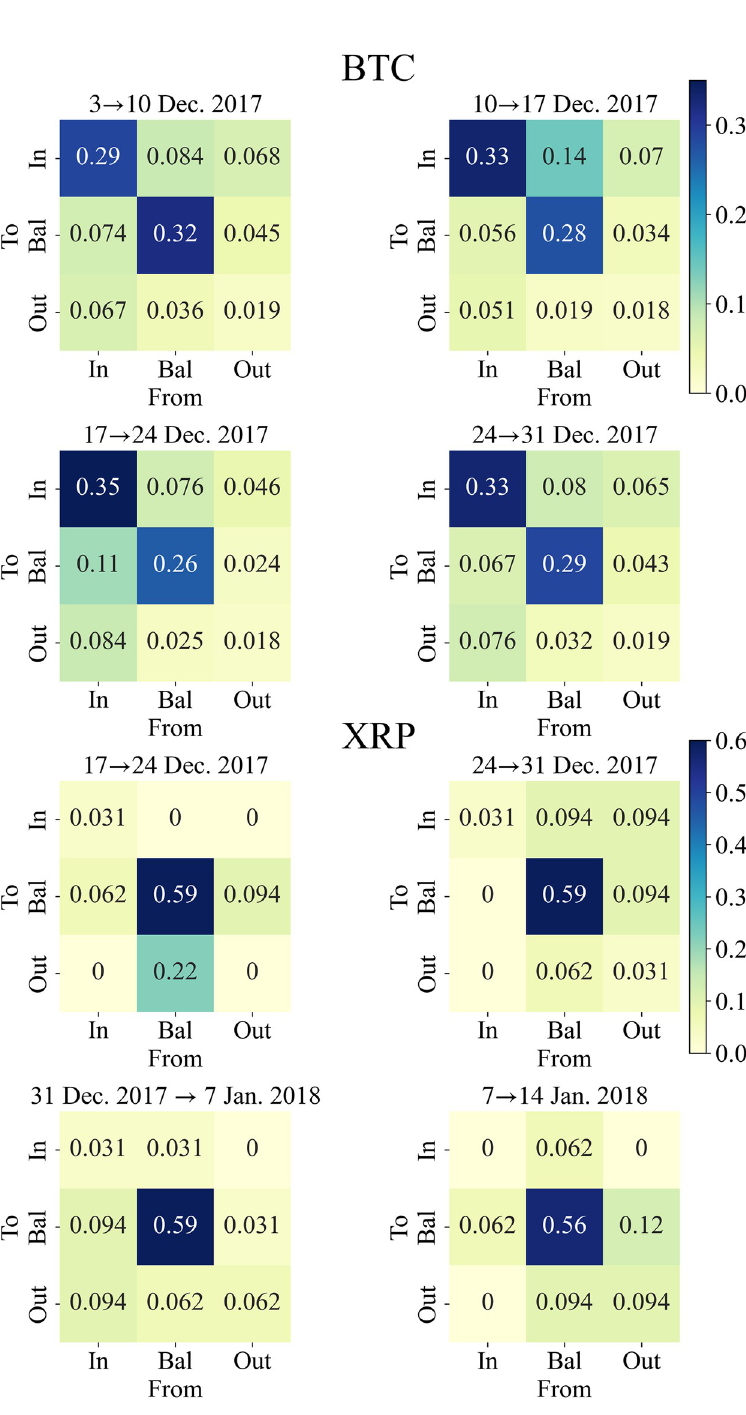
Fig 6. Heatmaps of transition rates around the price peak for Bitcoin (top) and XRP (bottom). Each component represents a transition from a column (From) element to a row (To) element. n ! m Dec. 2017 means the transition rate from the week starting at n to at m Dec.